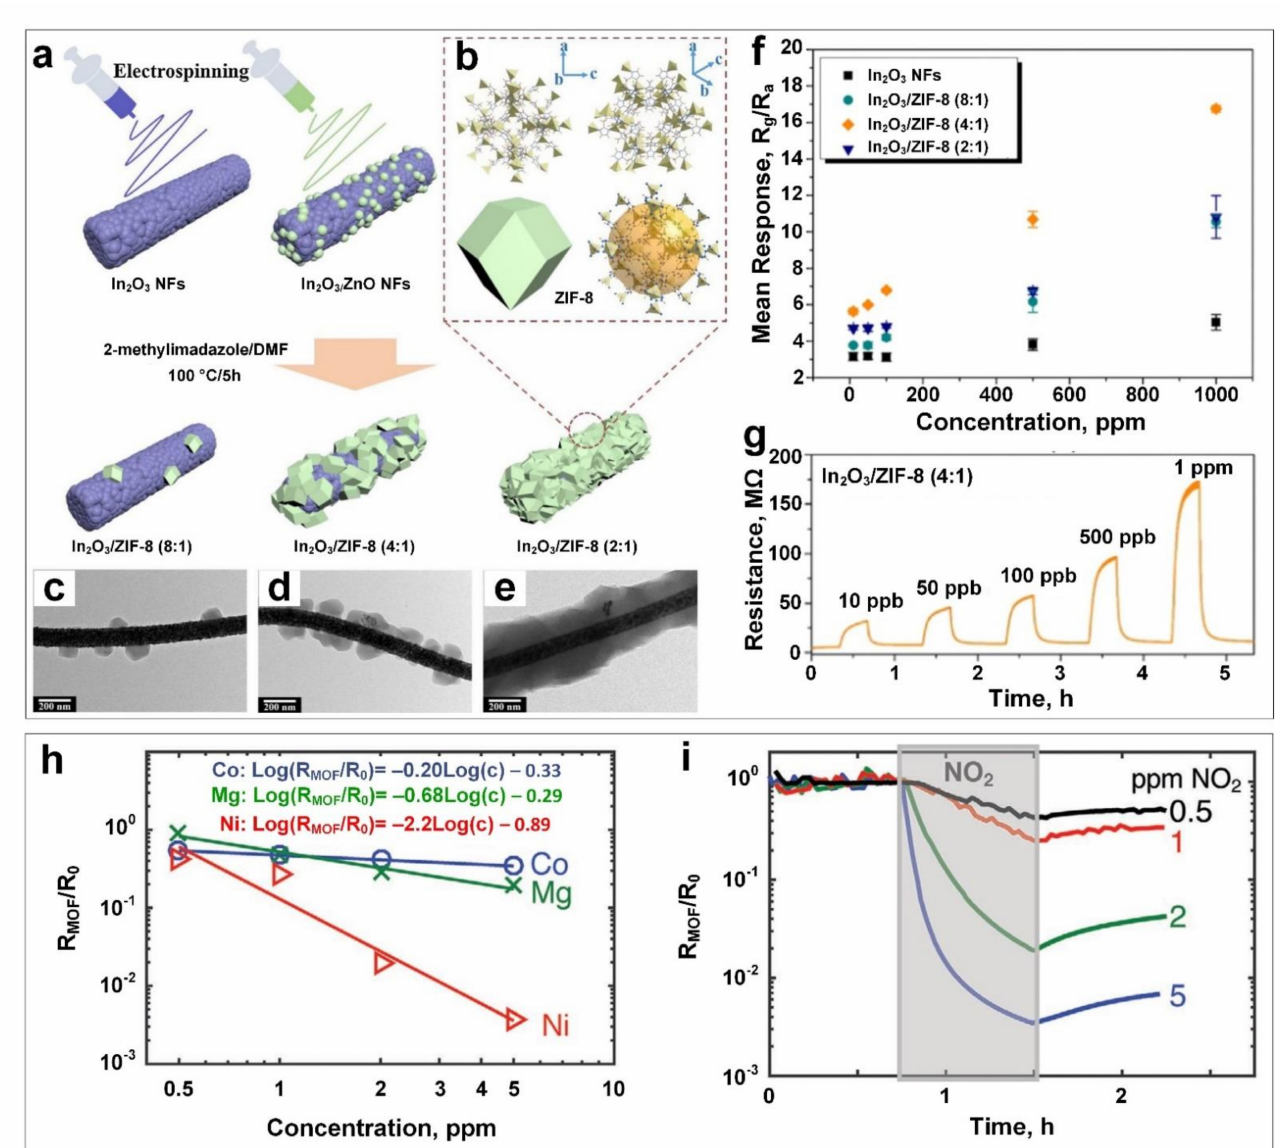
Figure 2. ( a ) Schematic diagram of In 2 O 3 /ZIF-8 nanocomposite fabrication. ( b ) ZIF-8 structure. TEM images of In 2 O 3 /ZIF-8 (8:1) ( c ), In 2 O 3 /ZIF-8 (4:1) ( d ), and In 2 O 3 /ZIF-8 (2:1) ( e ). ( f ) Mean response versus concentration for pure In 2 O 3 and its composites with ZIF-8. ( g ) Typical dynamic response curves of In 2 O 3 /ZIF-8 (4:1) sensors towards NO 2 gas at different concentrations at 140 ◦ C. Reproduced with permission from [87] Elsevier, 2019. ( h ) The relationship of response versus NO 2 gas concentration for different M − MOF − 74 (M = Co, Mg, Ni). ( i ) The dynamic response curves of M − MOF − 74 for exposure to 0.5, 1, 2 and 5 ppm NO 2 gas at 50 ◦ C. Reproduced with permission from [86] Wiley-VCH,